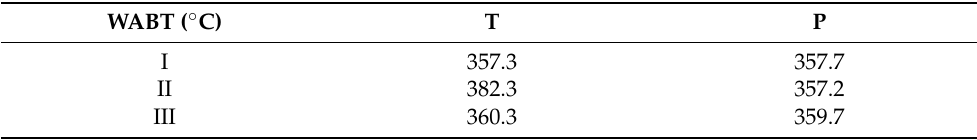
Table 5. Value of the WABT for each condition.